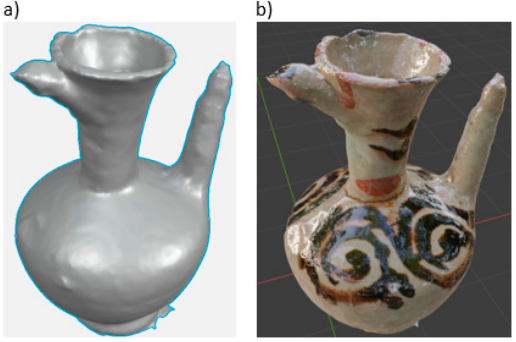
Figure 12. The appearance of the digital 3D model of the jug obtained by the SfM method after smoothing the surface: ( a ) without texture, ( b ) with texture.